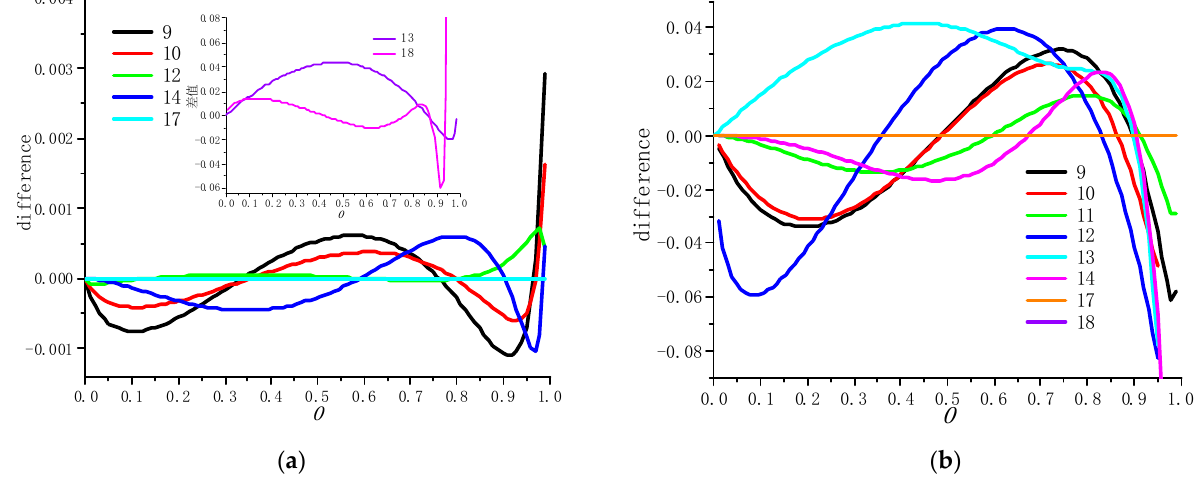
Figure 3. The difference between ( a ) Equation (4), ( b ) Equation (3) and the existing reaction mechanism function. It can be seen from Figure 3 that Equation (4) can characterize the existing reaction mechanism functions in Table 1 as long as appropriate parameter values of q , m , n and p are selected. Compared with Equation (3), Equation (4) shows higher accuracy and applicability in the whole conversion range between 0 and